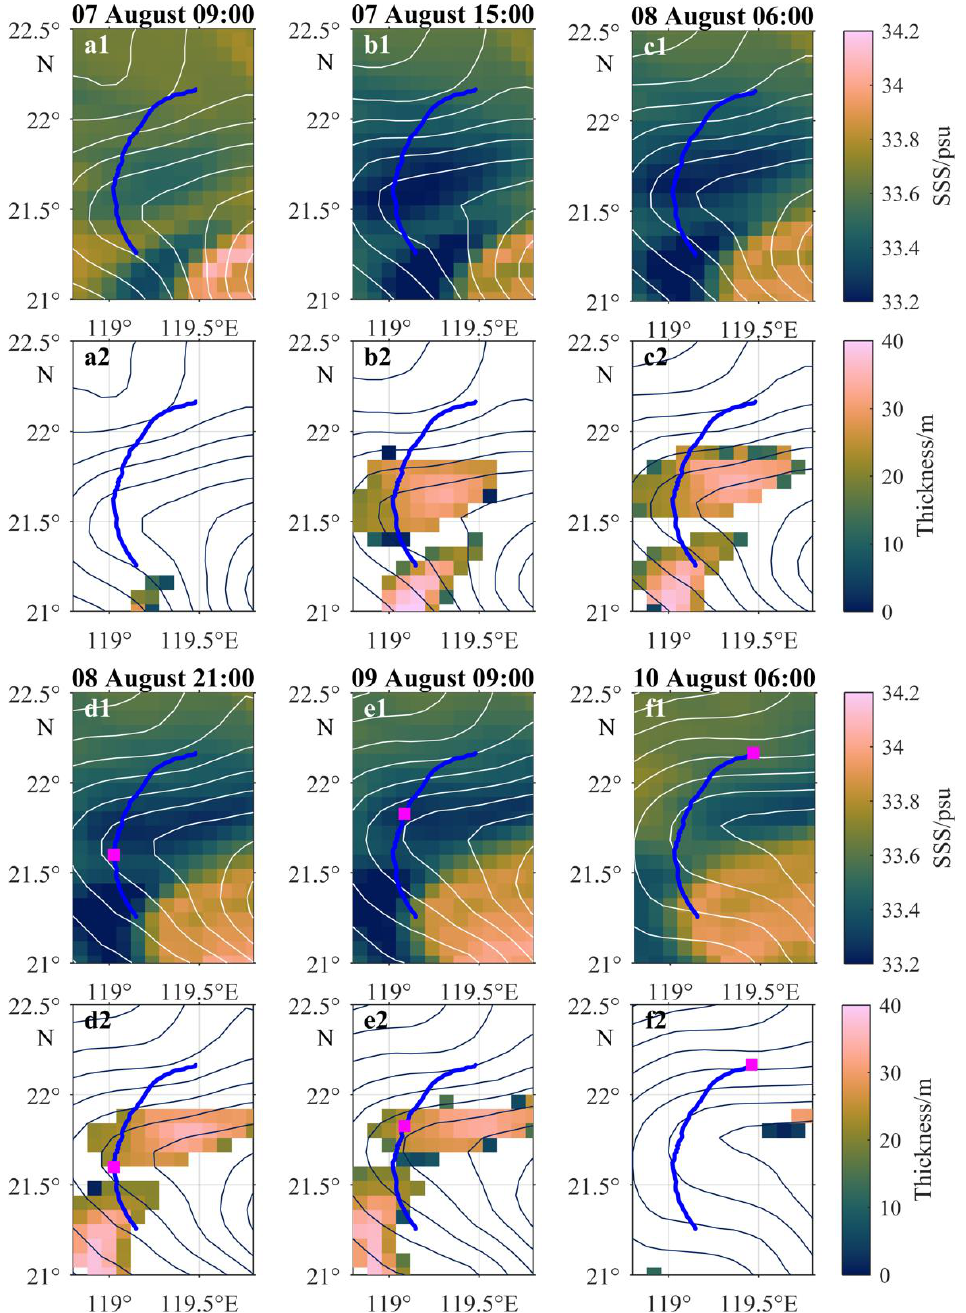
Figure 5. ( a1 – f1 ) Sea surface salinity (colored) and sea surface height (white contours, with a contour interval of 0.025 m) from the HYCOM Analysis data. ( a2 – f2 ) Thickness of the low-salinity water layer (colored, according to the 33.35 psu salinity criteria) and sea surface height (black contours, with a contour interval of 0.025 m) from HYCOM Analysis data. The blue curve indicates the R/V track during the observation. The magenta squares indicate the R/V position.